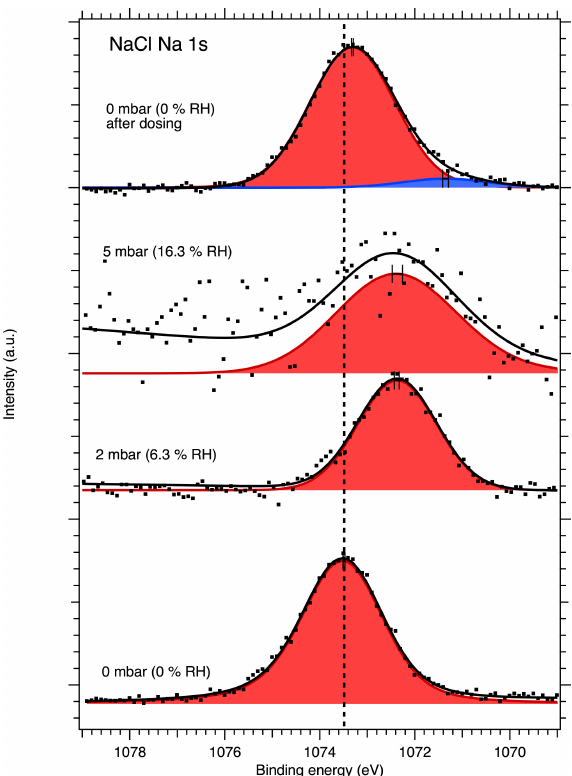
Figure 1. Na 1s XPS spectra of NaCl aerosol particles recorded at different water vapor pressures (relative humidities, RH). The point markers show the recorded data and the solid lines the fit envelope curve. The spectra are fit using a single symmetric Voigt peak shown in red with an additional peak in blue necessary to explain the spec- trum at 0mbar after water exposure. The dashed vertical line shows the binding energy of Na 1s at 0mbar pressure (0% RH) at the beginning of the experiments. Error bars show the estimated un- certainty in the peak position from Monte Carlo analysis. Photon energy was 1486.6eV from the Al anode.